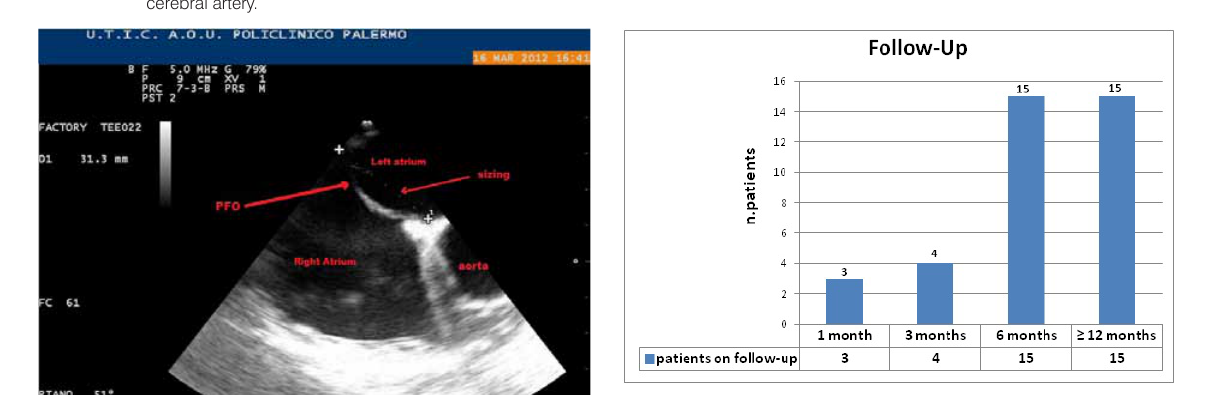
Figure 1. cTCD- microembolic signals (MES) in the middle cerebral artery.